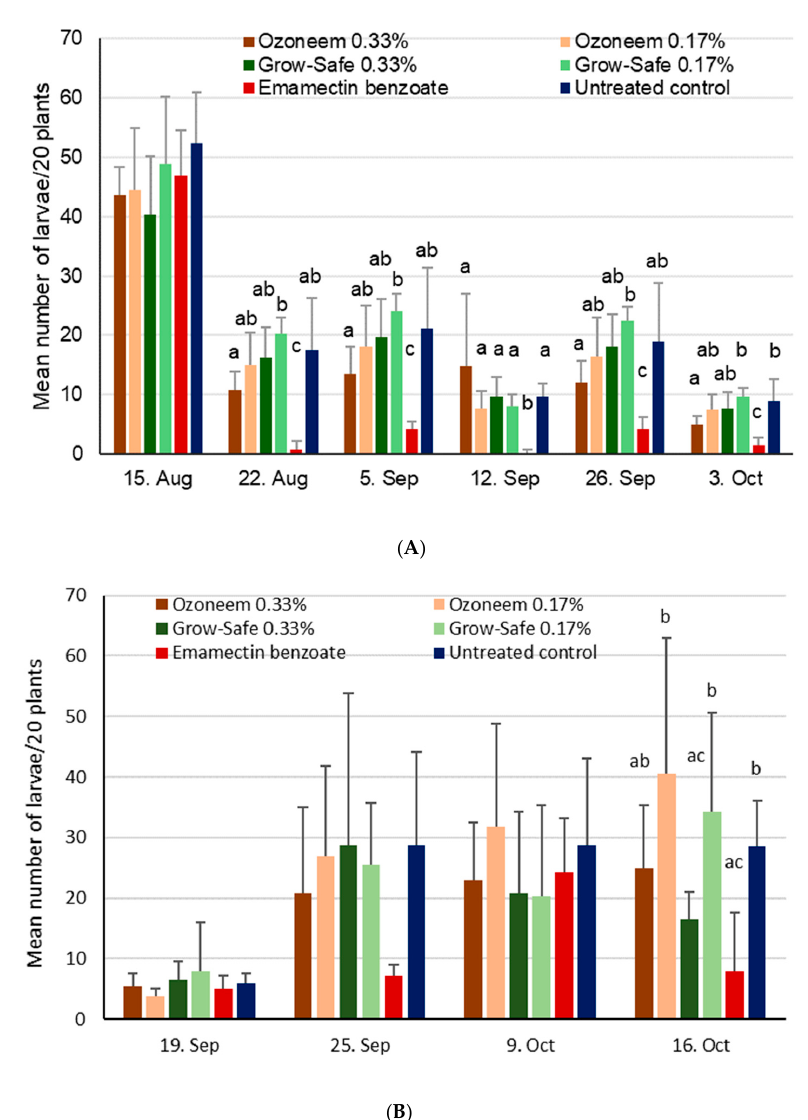
Figure 4. Mean number of FAW larvae + SD found on 20 maize plants in the neem trial during vegetative growing stages conducted in 2018. Within a given date, bars sharing the same letters are not significantly different from each other. ( A ) Site 1 near Wa, Upper West, Ghana, where treatments were applied on 16 August, 6 September, and 27 September. ( B ) Site 2 near Accra, Ghana, where treatments were applied on 20 September and 10 October. Maize damage scores at site 1 (according to the Davis scale) were not significantly different during the first assessment data period (i.e., before treatments were applied; χ 25,18 = 9.3, p = 0.10) (Figure 5). Four weeks later, on 12 September, and after treatments had been applied twice, significant differences were obtained ( χ 25,18 = 82.8, p < 0.001), with higher values shown for the Ozoneem 0.17% treatment and the untreated control. Significant differences in maize plant damage were also found at the last assessment date ( χ 25,18 = 30.7, p < 0.001), with all treatments showing similar values of 2.5 to 3, except the untreated control. At site 2, virtually no damage was found on plants before treatments were applied, but substantial damage was observed on 25 September, with significant differences observed among treatments ( χ 25,18 = 35.6, p < 0.001). Two more assessments of crop damage revealed no significant differences among treatments on 9 October ( χ 25,18 = 9.3, p = 0.10) and 16 October ( χ 25,18 = 11.2, p = 0.06). ( A ) ( B ) Figure 5. Mean crop damage induced by FAW + SD found in the neem trial during vegetative growing stages conducted in 2018. Within a given date, bars sharing the same letters are not significantly